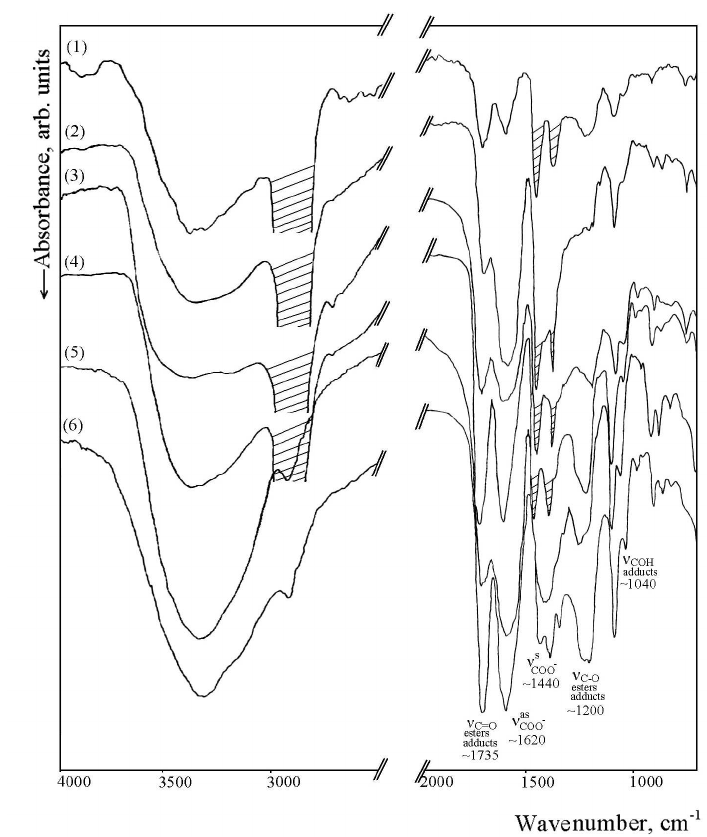
Fig. 2 IR spectra of Mn(Cl)Cit-120 (1), Mn(N)Cit-80 (2), Mn(N)Cit-120 (3), LaMn(Cl)Cit-120 (4), in nujol mulls and of LaCaMn(Cl)Cit (5) and LaMn(N)Cit-60 (6) in KBr